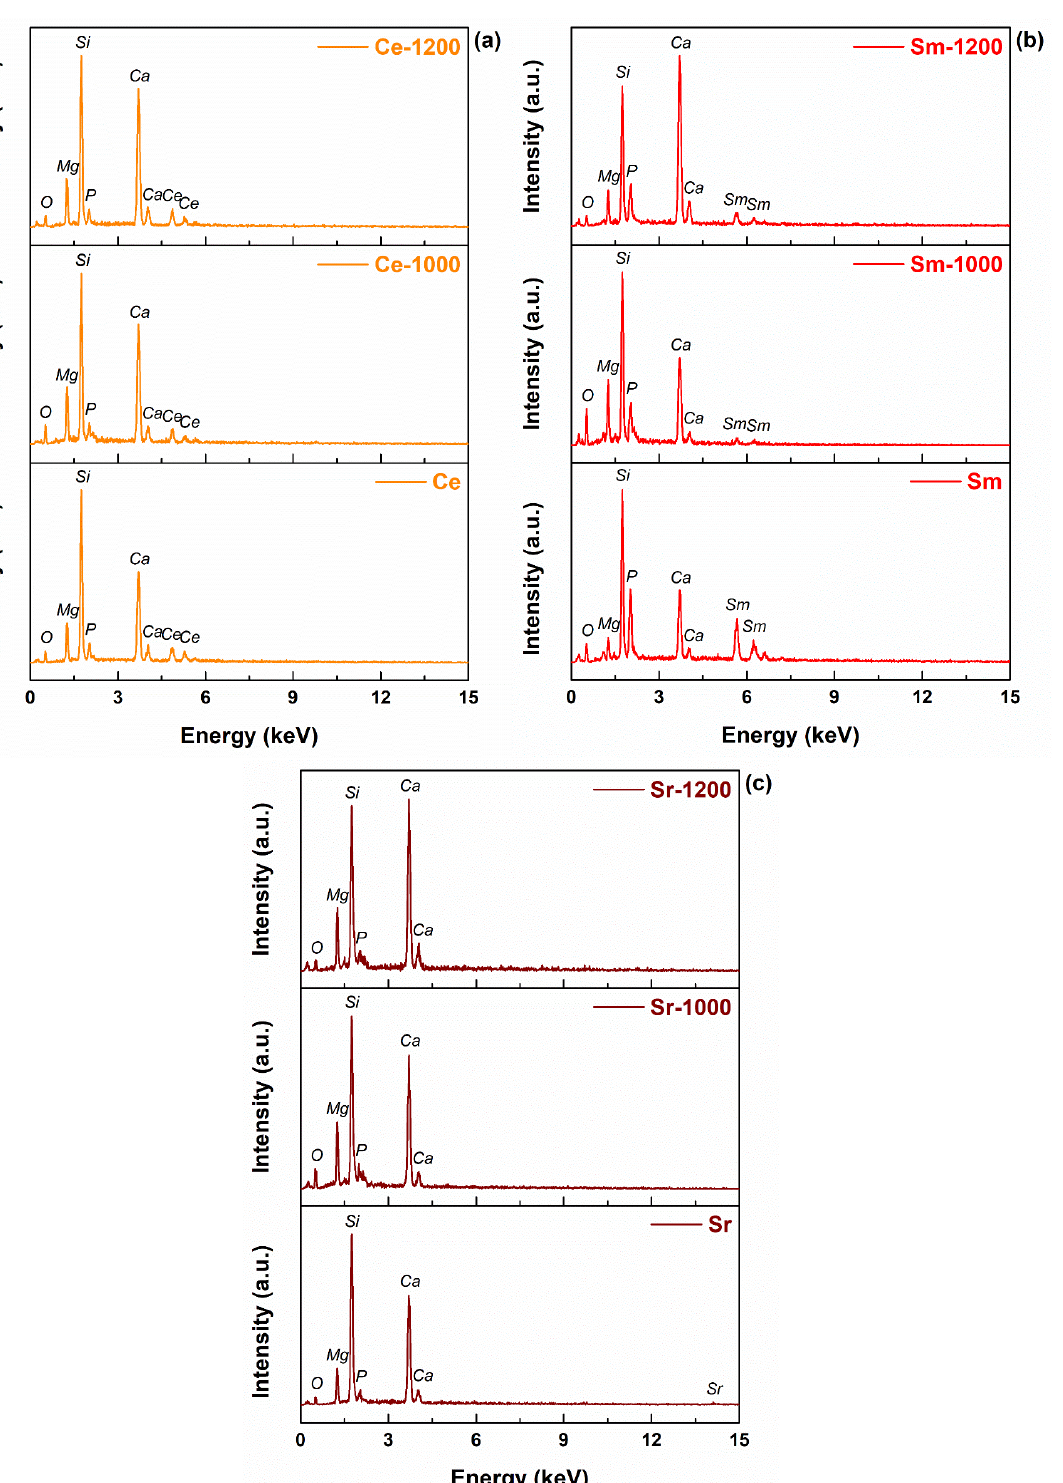
Figure 5. EDS spectra of the developed materials: ( a ) Ce-containing composition, ( b ) Sm-containing composition and ( c ) Sr-containing composition.